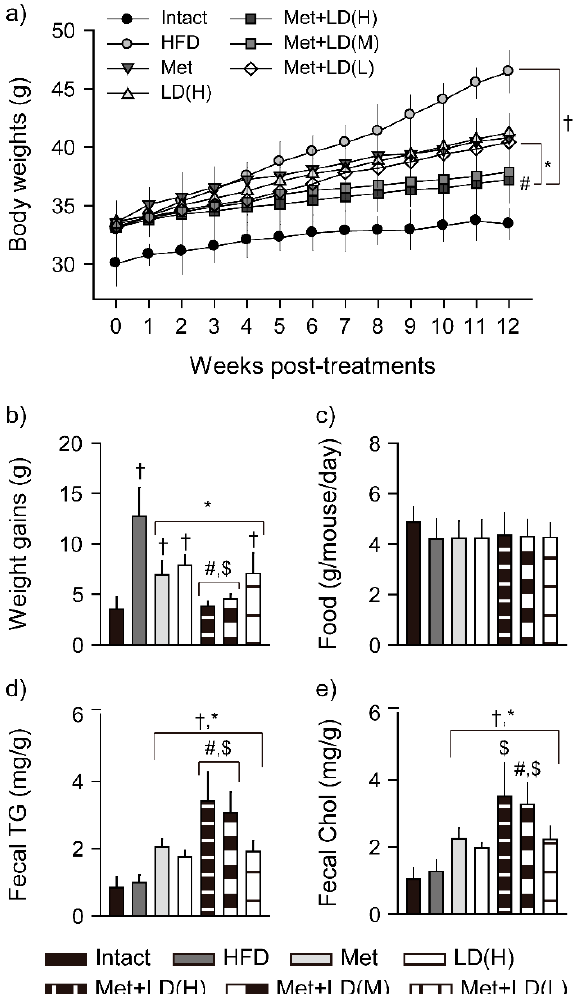
Figure 1. Combination effects on weight loss and energy metabolism. ( a ) Kinetic changes in body weights. ( b ) Total weight gains for 12 weeks. ( c ) Food consumption. ( d , e ) Fecal excretion of triglyceride (TG) and total cholesterol (Chol). Values are represented as the means ± standard deviations (SDs) ( n = 8). †, *, #, and $: p < 0.05 vs. the Intact, HFD control (HFD), Met, and LD(H) groups, respectively.